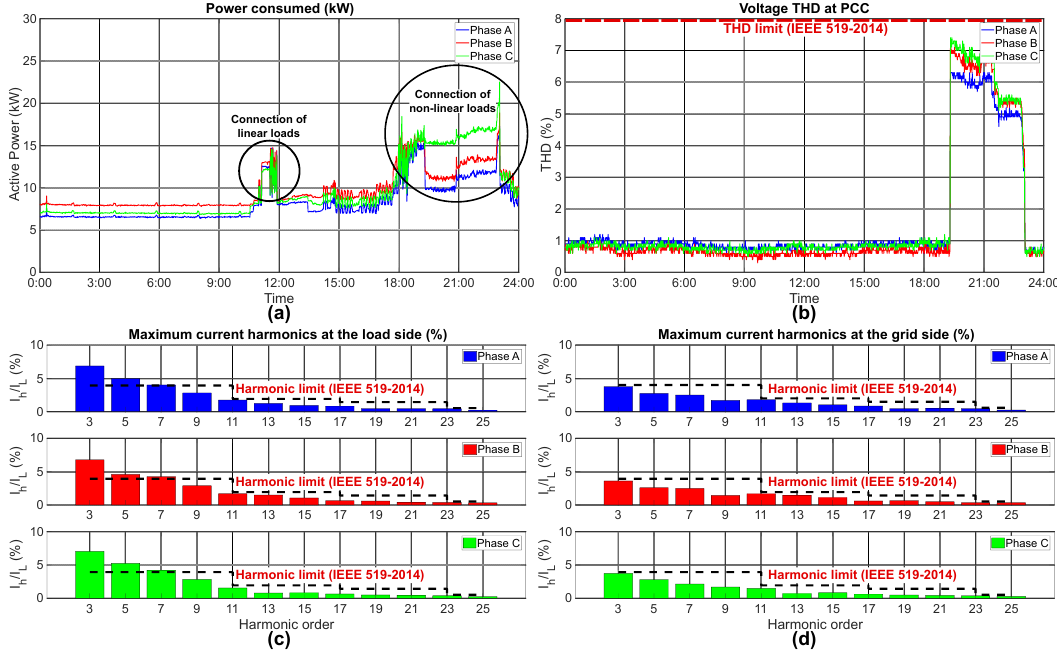
Figure 13. Measurements of the football stadium: ( a ) active power; ( b ) voltage THD; ( c ) maximum current harmonics consumed by the loads; ( d ) maximum current harmonics at the grid